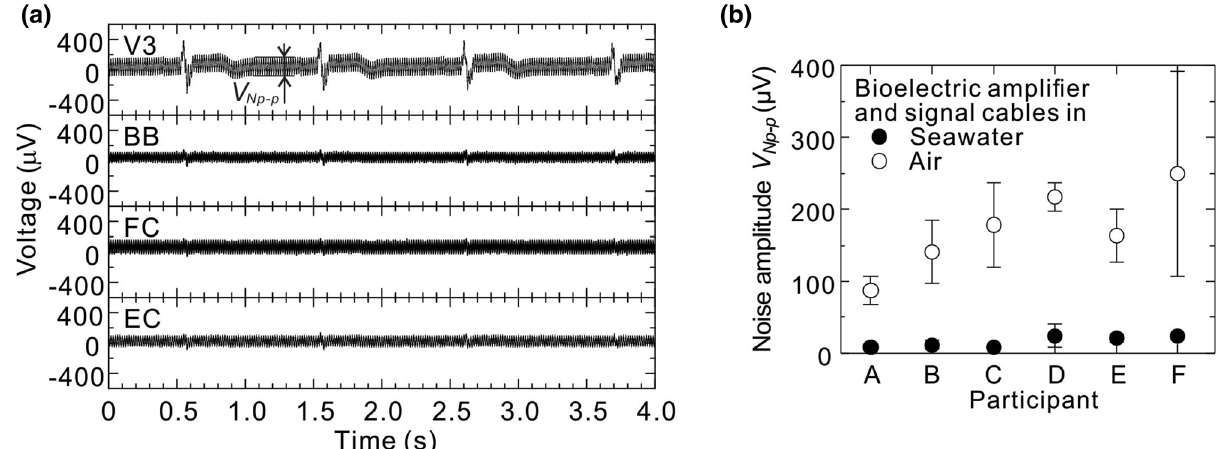
Figure 7. ( a ) Example of bioelectric signals of the participant in rest state when the bioelectric amplifier and signal cables are kept in air (participant A) and ( b ) noise amplitudes included in the bioelectric signals of the participant in rest state. Measurement accuracies of the waveforms at thorax (V3), biceps brachii (BB), flexor carpi (FC), and extensor carpi (EC) were 5.3, 2.6, 2.6, and 2.6 µV,